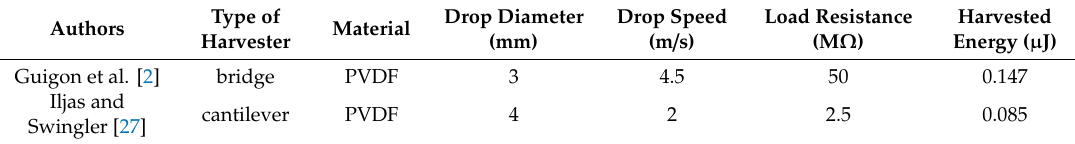
Table 2. Literature values of harvested